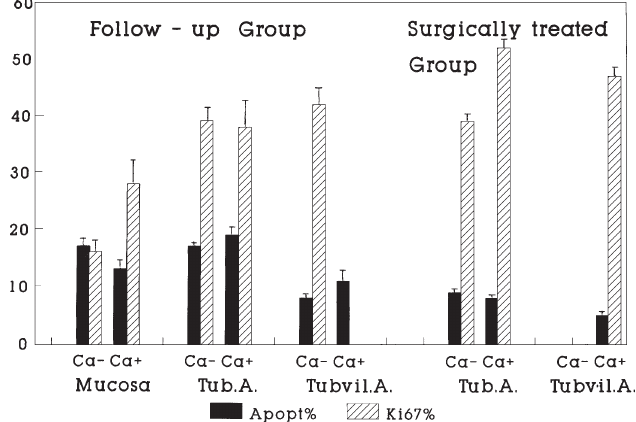
Fig. 1. Percentages of subdiploid apoptotic and Ki67 positive cells in colorectal mucosa and adenomas (A) ( M ± m ).